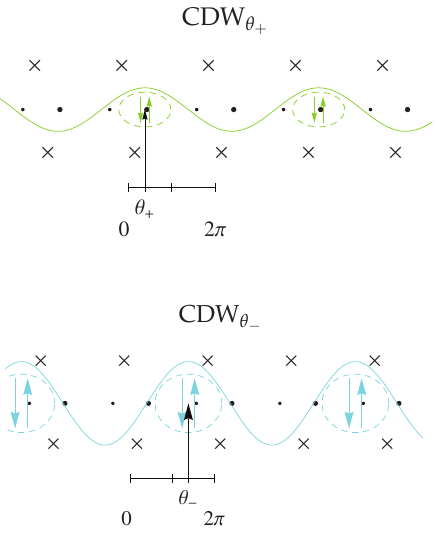
) 2 k F charge-density-wave and their respective phase ( θ −